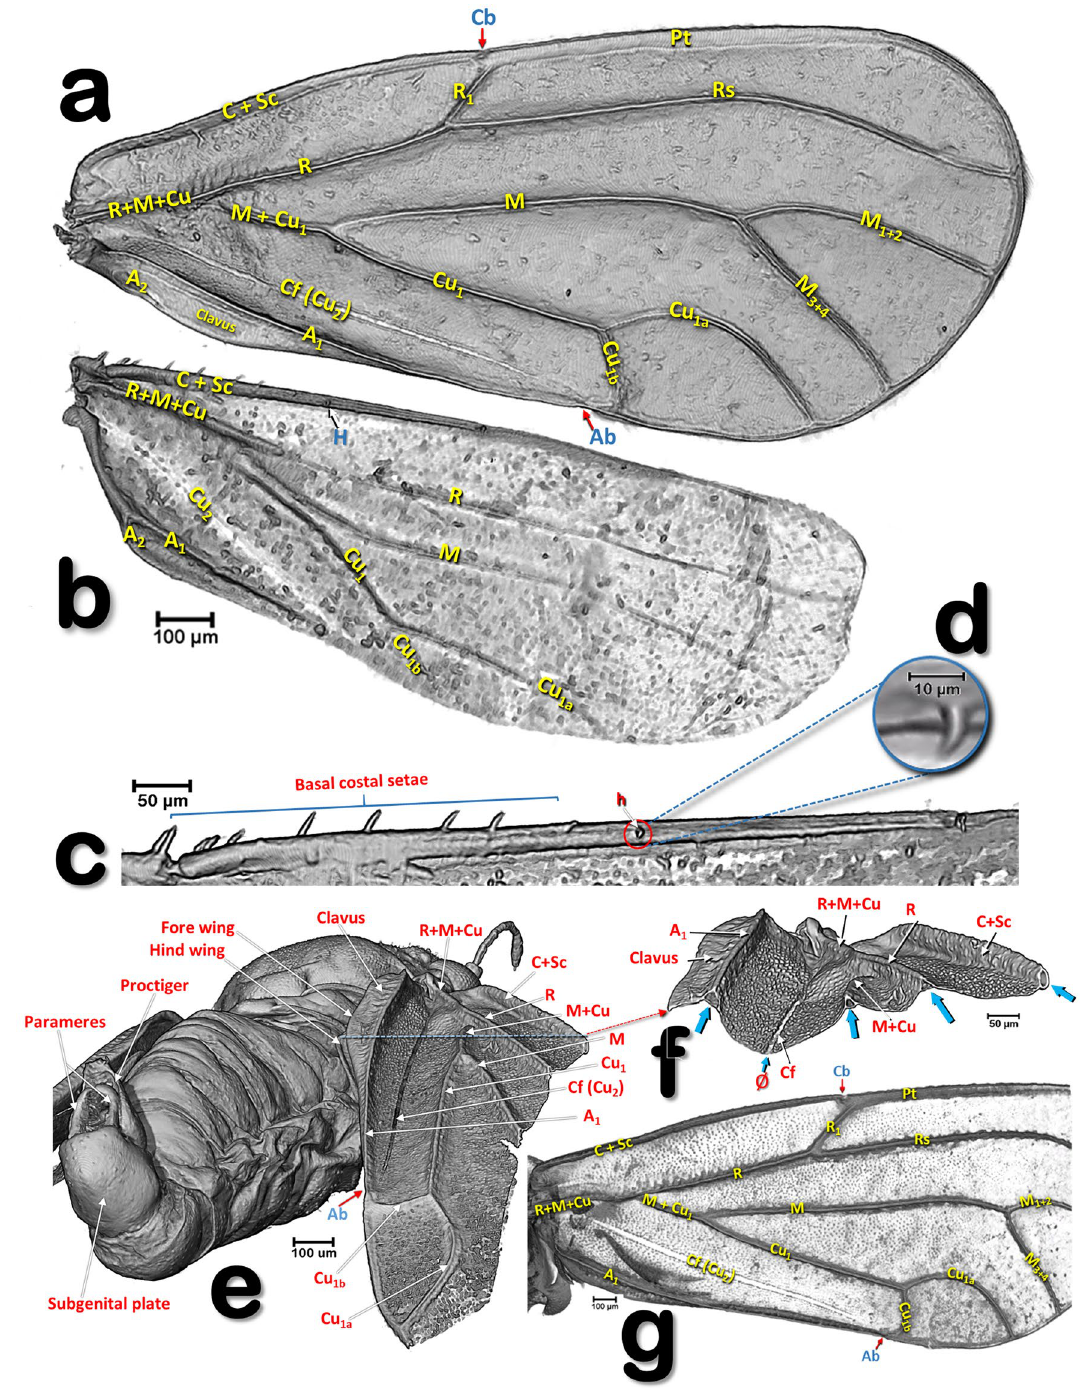
Figure 4. Volume-rendered images of the wings and veins of Diaphorina citri : left wings of a female in a ventral view ( a – d ) and right forewing of a male ( g ), in different views showing the dorsal surface ( e – g ). General shape of the wings and veins ( a , b ). Details of the dorsal fore basal margin of the hind wing ( c ). Detail of the hamulus ( d ). Right-lateral posterior view of a male showing veins and folds of the right wing ( e ). Details of the basal right forewing ( f ), as a result of a virtual cut marked with a red dashed line in e (blue arrows indicate the transversal cut of the vein tubes, the symbol ‘Ø’ indicates the non-tubular structure of the cubital fold. Abbreviations: A = anal vein; Ab = anal break; C = costa vein; Cb = costal break; Cf = cubital fold; Cu = cubital vein; H = hamulus; M = median vein; R = radius vein; Rs = radial sector